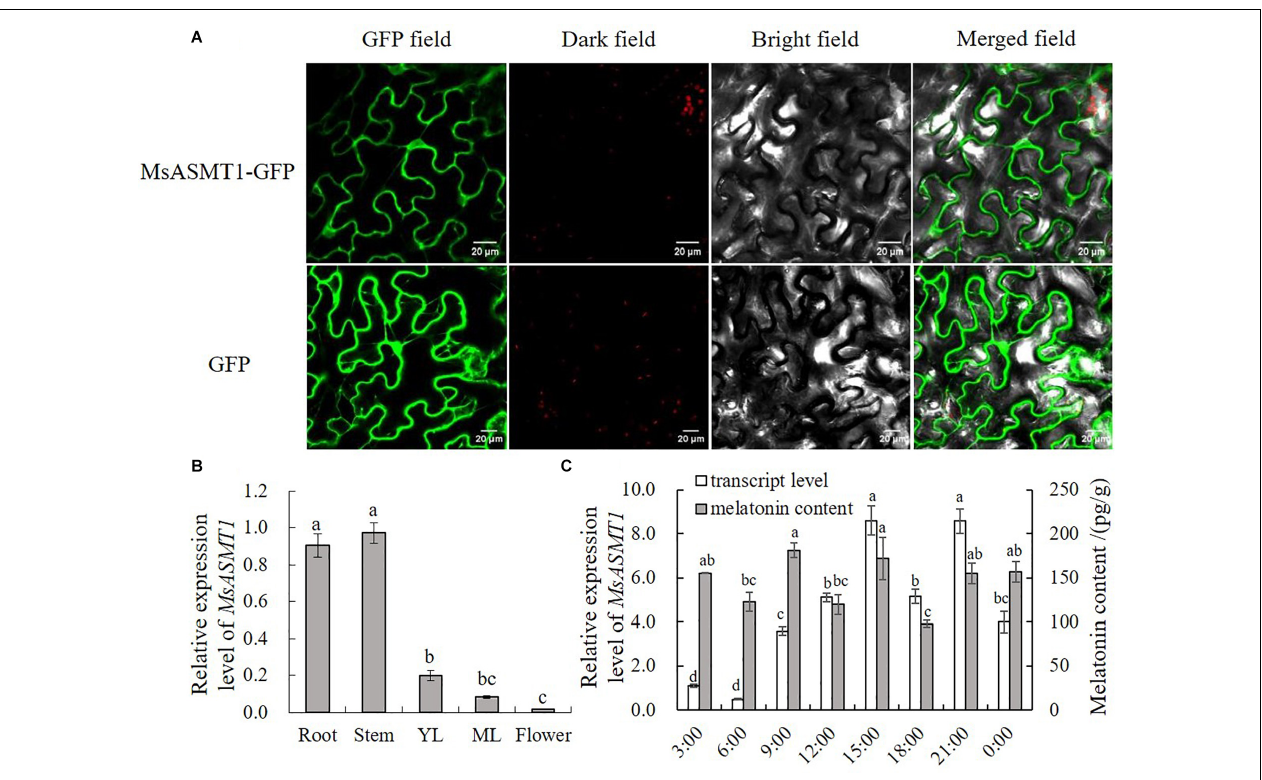
FIGURE 1 | Characterization of MsASMT1. (A) Subcellular location of MsASMT1 in Nicotiana tabacum. From left to right: green fluorescence, dark field, bright field, merged field of MsASMT1-GFP and GFP; (B) Relative expression level of MsASMT1 in different tissues of alfalfa. YL, young leaves, ML, mature leaves. The letters indicate the differences among different tissues of alfalfa according to ANOVA analysis ( p < 0.05); (C) Circadian rhythm of MsASMT1 transcript levels and melatonin content in alfalfa throughout one day. Data are presented as means ± SE ( n = 3), the letters indicate the differences of MsASMT1 transcript levels and melatonin content respectively among different time points according to ANOVA analysis ( p <